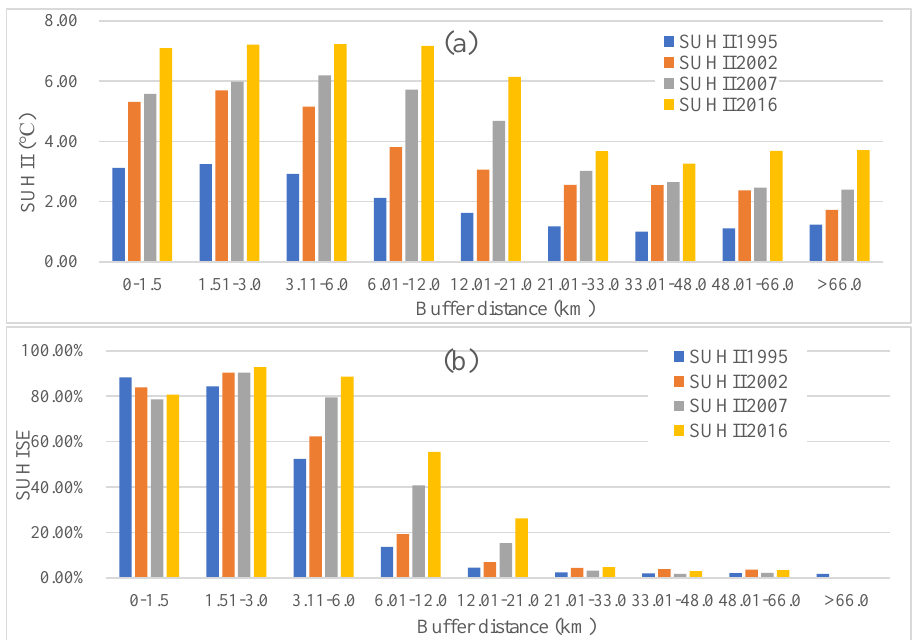
Figure 4. Zonal statistics of summertime SUHII ( a ) and SUHISE ( b ) in Greater Hefei during the study period.